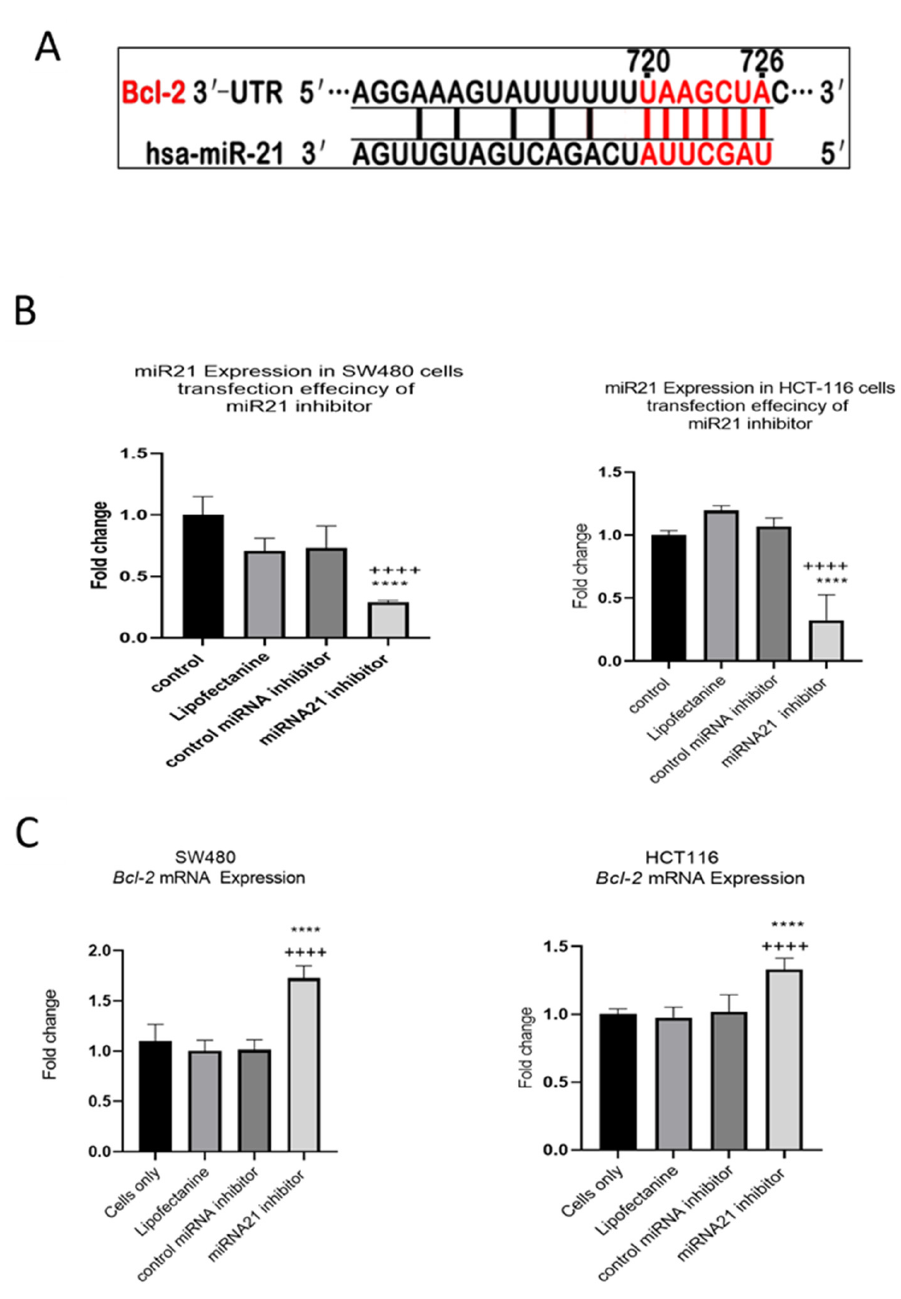
Figure 9. Expression of miR ‐ 21 target gene BCL ‐ 2 in SW480 and HCT116 cells. ( A ) The 3 ‵ ‐ UTR of BCL ‐ 2 ‐ mRNA is a target for miR ‐ 21 and the matching sequence is marked in red. The miRNA targets were predicted by Target Scan Human Release 6.2 (http://www.targetscan.org) (accessed